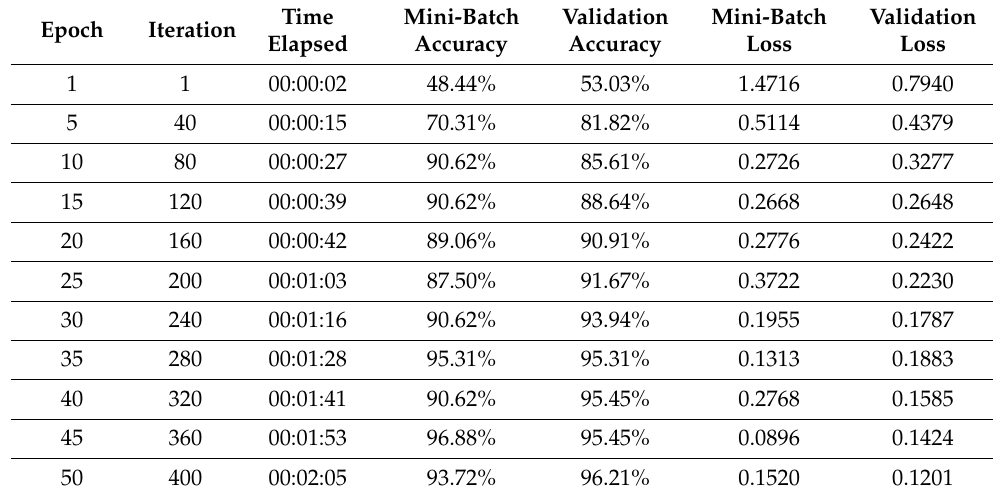
Table 6. AlexNet training process.